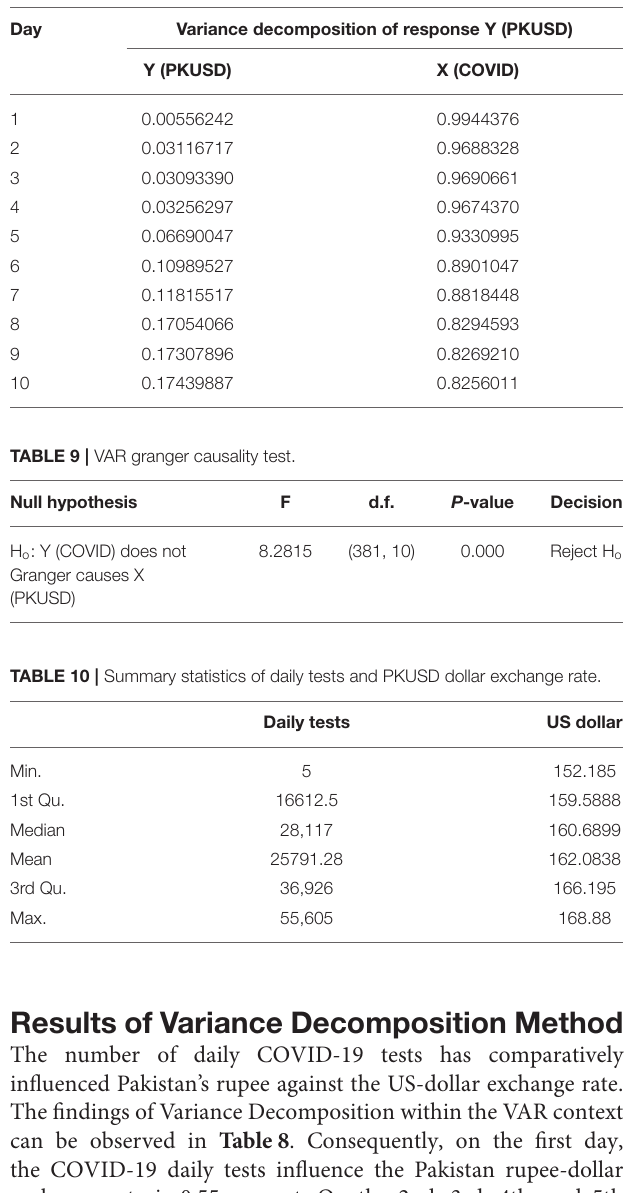
TABLE 8 | Variance decomposition.